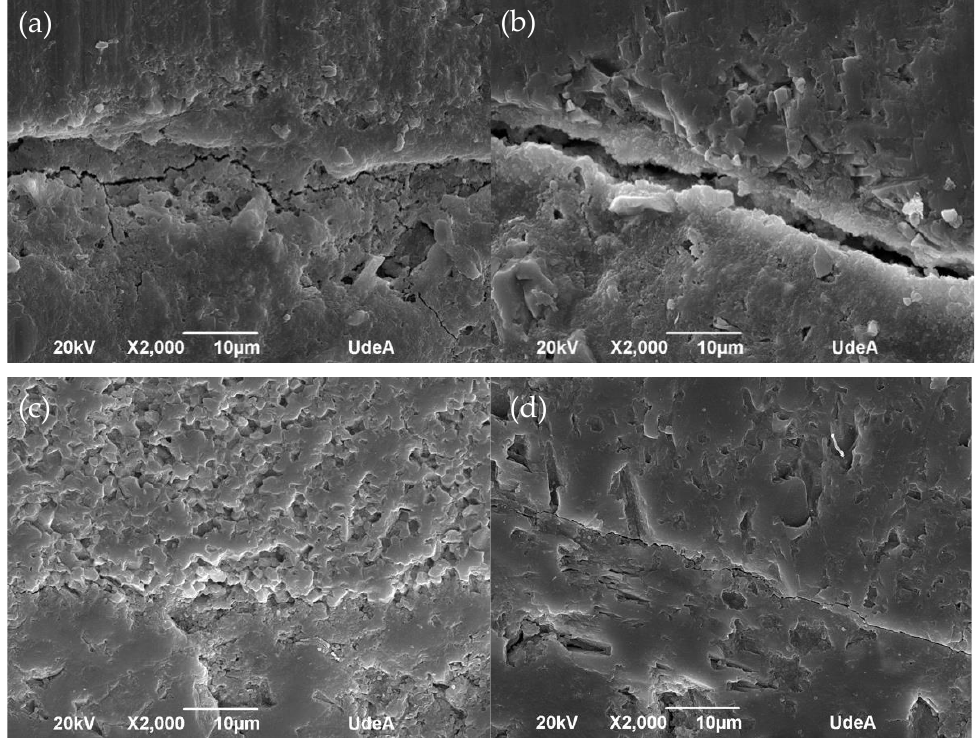
Figure 19. SEM observation of ITZ of mortar: ( a ) uncarbonated (0% treated RFA); ( b ) carbonated (0% treated RFA); ( c ) uncarbonated (100% treated RFA); ( d ) carbonated (100% treated RFA).